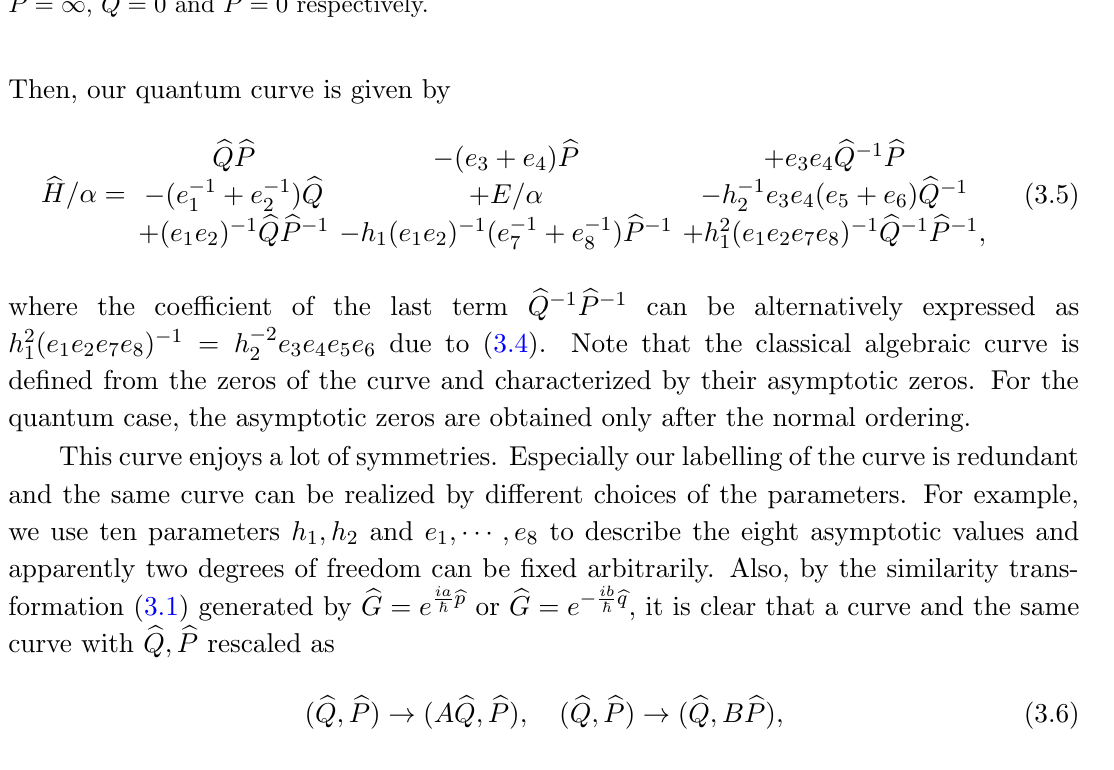
Figure 2 . The asymptotic values of the D 5 del Pezzo curve, ( 1 ; e (cid:0) 1 (0 ; h (cid:0) 1 e 5 ), (0 ; h (cid:0) 1 e 6 ), ( h 1 e (cid:0) 1 ; 0), ( h 1 e (cid:0) 1 ; 0). The four lines denote \lines at in(cid:12)nity" b Q = 1 , 2 2 7 8 b P = 1 , b Q = 0 and b P = 0